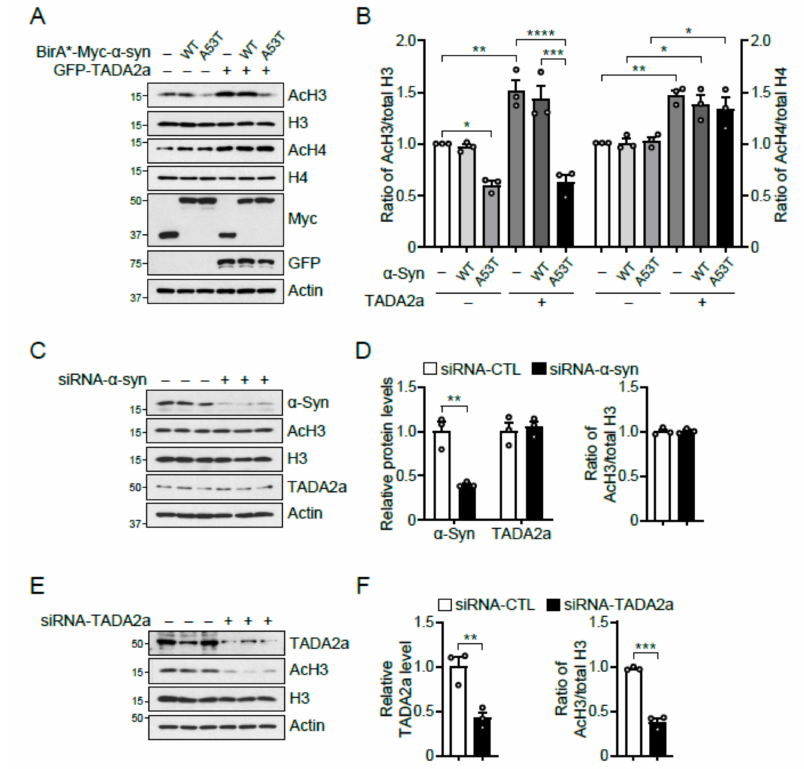
Figure 4. α -Syn A53T inhibits histone H3 acetylation by blocking TADA2a. ( A ) Immunoblot analysis of AcH3, histone H3, AcH4, histone H4, Myc, and GFP in SH-SY5Y cells transfected with BirA*-fused, Myc-tagged α -syn WT and A53T, and GFP-tagged TADA2a normalized to β -actin. ( B ) Quantification of the ratio of AcH3/total H3 and AcH4/total H4 from immunoblot analysis (A), n = 3 per group. ( C ) Immunoblot analysis of α -syn, AcH3, histone H3, and TADA2a in siRNA- α -syn knockdown SH-SY5Y cells normalized to β -actin. ( D ) Quantification of the levels of α -syn and TADA2a nor- malized to β -actin and the ratio of AcH3/total H3 from immunoblot analysis (C), n = 3 per group. ( E ) Immunoblot analysis of TADA2a, AcH3, and histone H3 in siRNA-TADA2a knockdown SH-SY5Y cells normalized to β -actin. ( F ) Quantification of the levels of TADA2a normalized to β -actin and the ratio of AcH3/total H3 from immunoblot analysis (E), n = 3 per group. Data = mean ± SEM. Statistical significance was determined by an unpaired, 2-tailed Student’s t -test (D and F) and ANOVA test with Tukey post hoc analysis (B). Differences were considered significant at p < 0.05. * p < 0.05, ** p < 0.01, *** p < 0.001, and **** p <